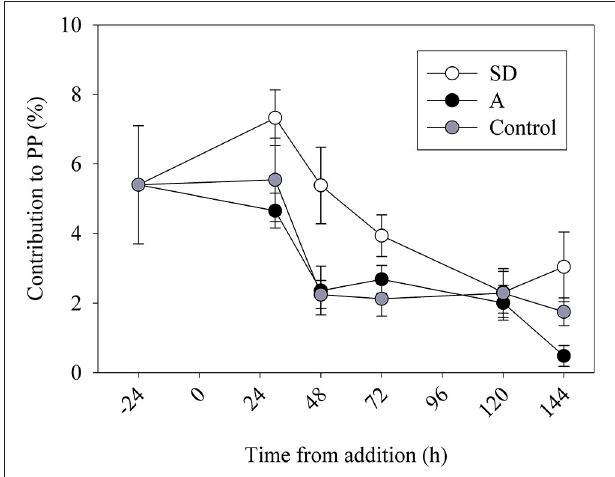
FIGURE 4 | The contribution of N 2 fixation to primary productivity (PP) in the control (gray), SD (white), and A (black) mesocosms.